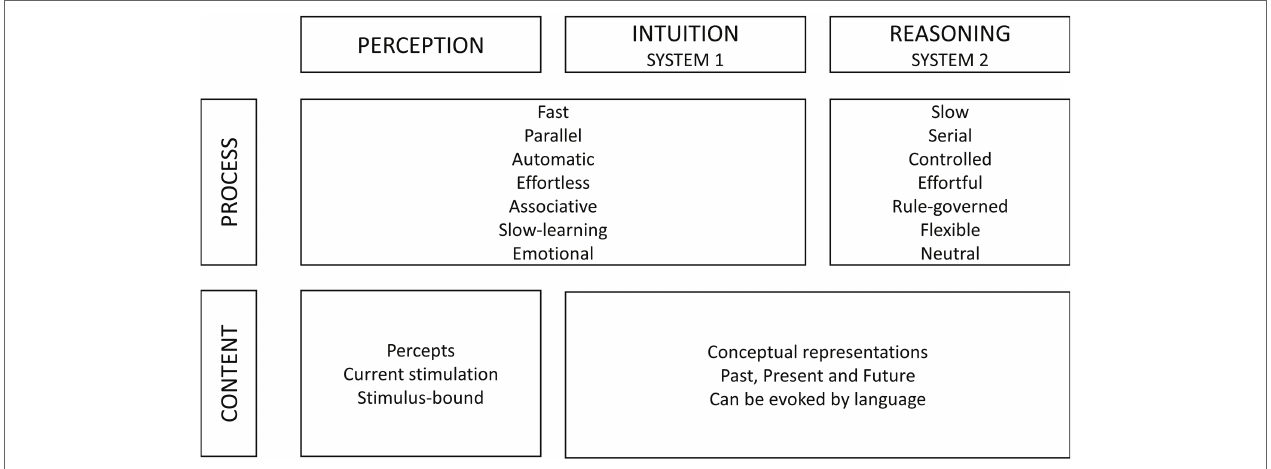
FIGURE 1 | Process and content in two cognitive systems. Reprinted from Kahneman (2003, p. 698), permission not